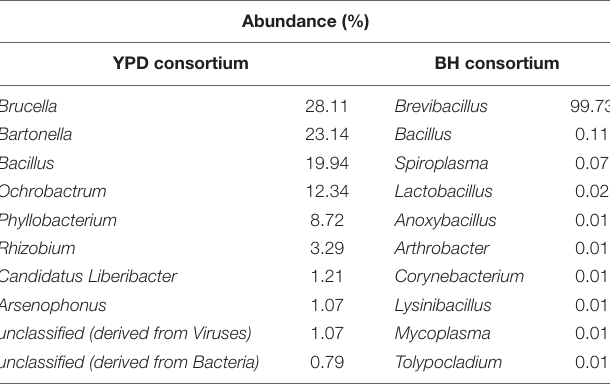
TABLE 2 | Frequency of the 10 most abundant genera in the consortia identified by shotgun metagenomic sequencing.